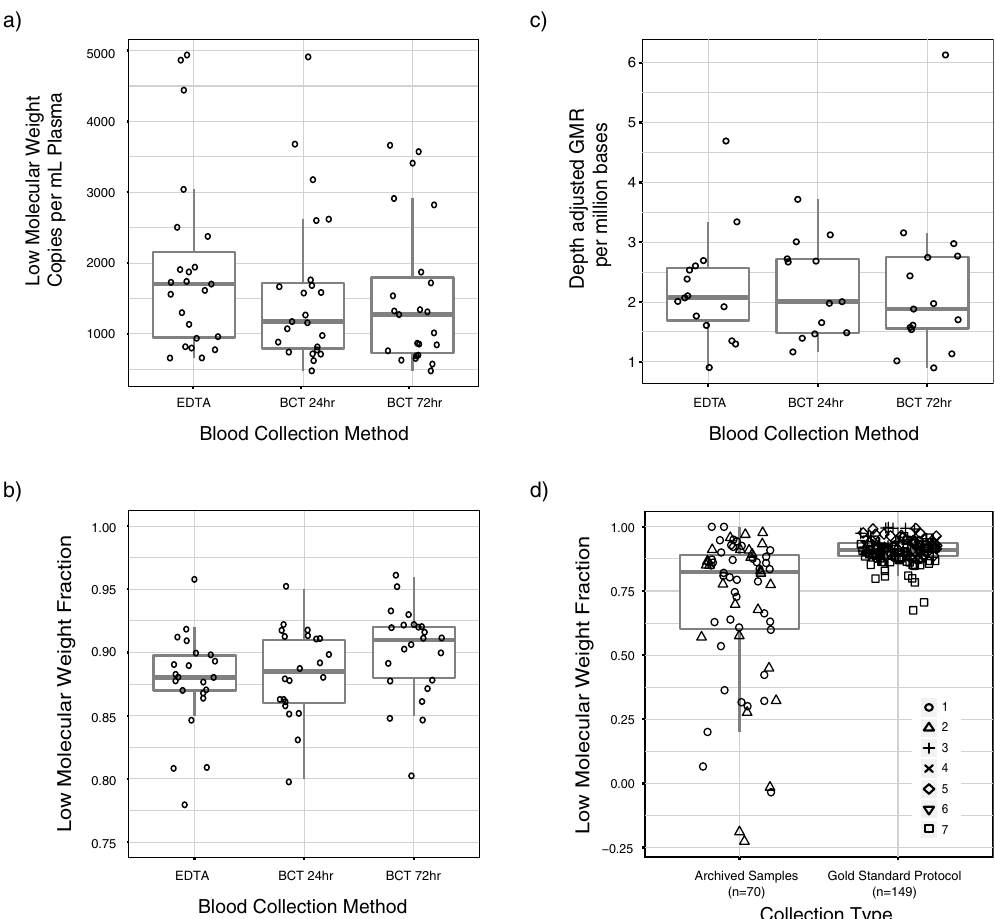
Figure 4. ( a , b , c ) Evaluation of blood collection protocols for cfDNA analysis using ddPCR and digital targeted sequencing. ( a , b ) Comparison of cfDNA yield (in LMW fragments/mL of plasma) and LMW fraction across 3 blood collection methods. Outliers at 0.67 LMW fraction for EDTA and at 0.71 LMW fraction for BCT 24 hr are not shown in ( b ) to enhance scaling. Paired samples from healthy volunteers were collected for this analysis. Comparison between EDTA, BCT 24 hr samples and BCT 72 hr samples showed no significant difference for yield or LMW fraction (ANOVA p-values > 0.05). Concentration of LMW fragments in DNA samples